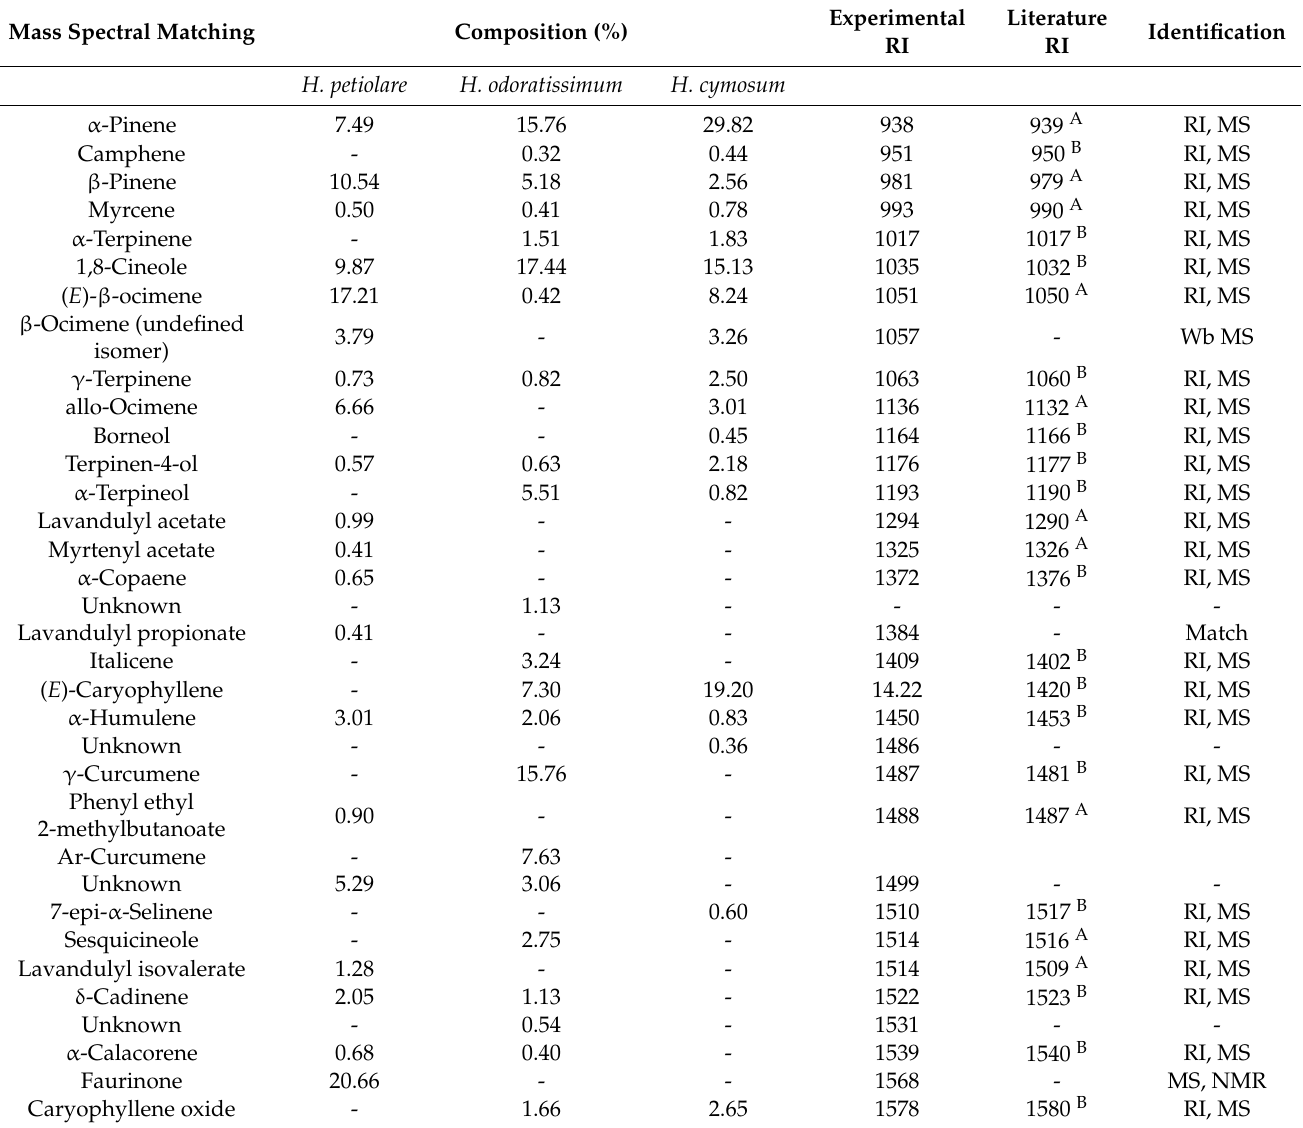
Table 2. GC-MS analysis of the Helichrysum essential